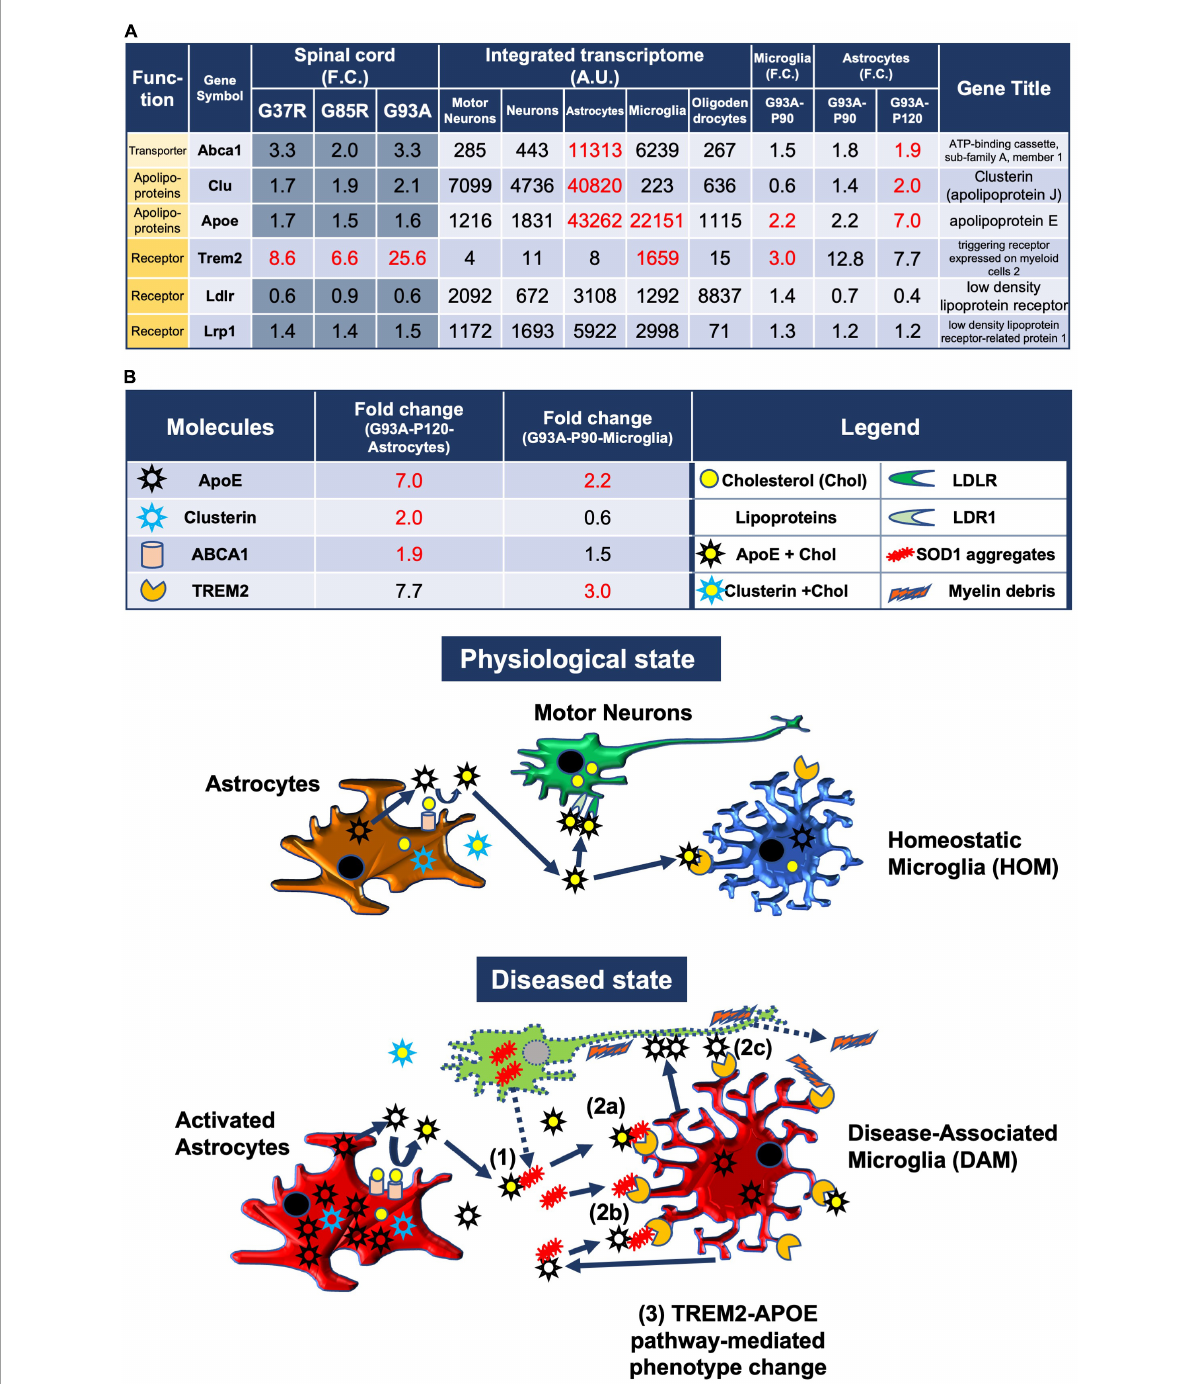
FIGURE5 Model of the pathomechanism among different cell types in spinal cords of mutant SOD1 mice related to TREM2, apolipoprotein E, and lipoproteins. (A) Gene expression analysis of the relevant transporter Abca1 , apolipoproteins Apoe and Clu , and receptors Trem2, Ldlr, and Lrp1 , using integrated and SOD1 G93A cell type transcriptomes. (B) Physiological state: cholesterol is transported from astrocytes to motor neurons and microglia via lipoproteins. Diseased state: (1) Mutant SOD1 aggregates are released from diseased motor neurons and bind to lipoproteins in the intercellular space. (2a) Microglia phagocytose SOD1 aggregate-lipoprotein complexes via TREM2. (2b) Microglia phagocytose SOD1 aggregates with or without ApoE via TREM2. (2c) Microglia phagocytose ApoE-bound motor neurons via TREM2. (3) TREM2-mediated phagocytosis changes the phenotype from HOM to DAM in microglia via ApoE signaling. Excessive DAM activation may contribute to exacerbation of ALS